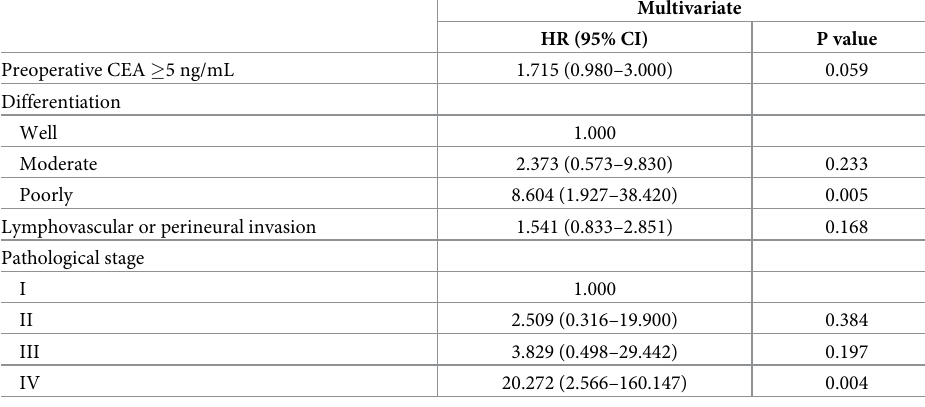
Group Y, patients � 50 years; Group O, patients > 50 years; HR, hazard ratio; CI, confidence interval; CEA, carcinoembryonic antigen; MSI, microsatellite instability; MSI-H, high-frequency MSI; MSI-L, MSI low-frequency; MSS, microsatellite stability; LN, lymph